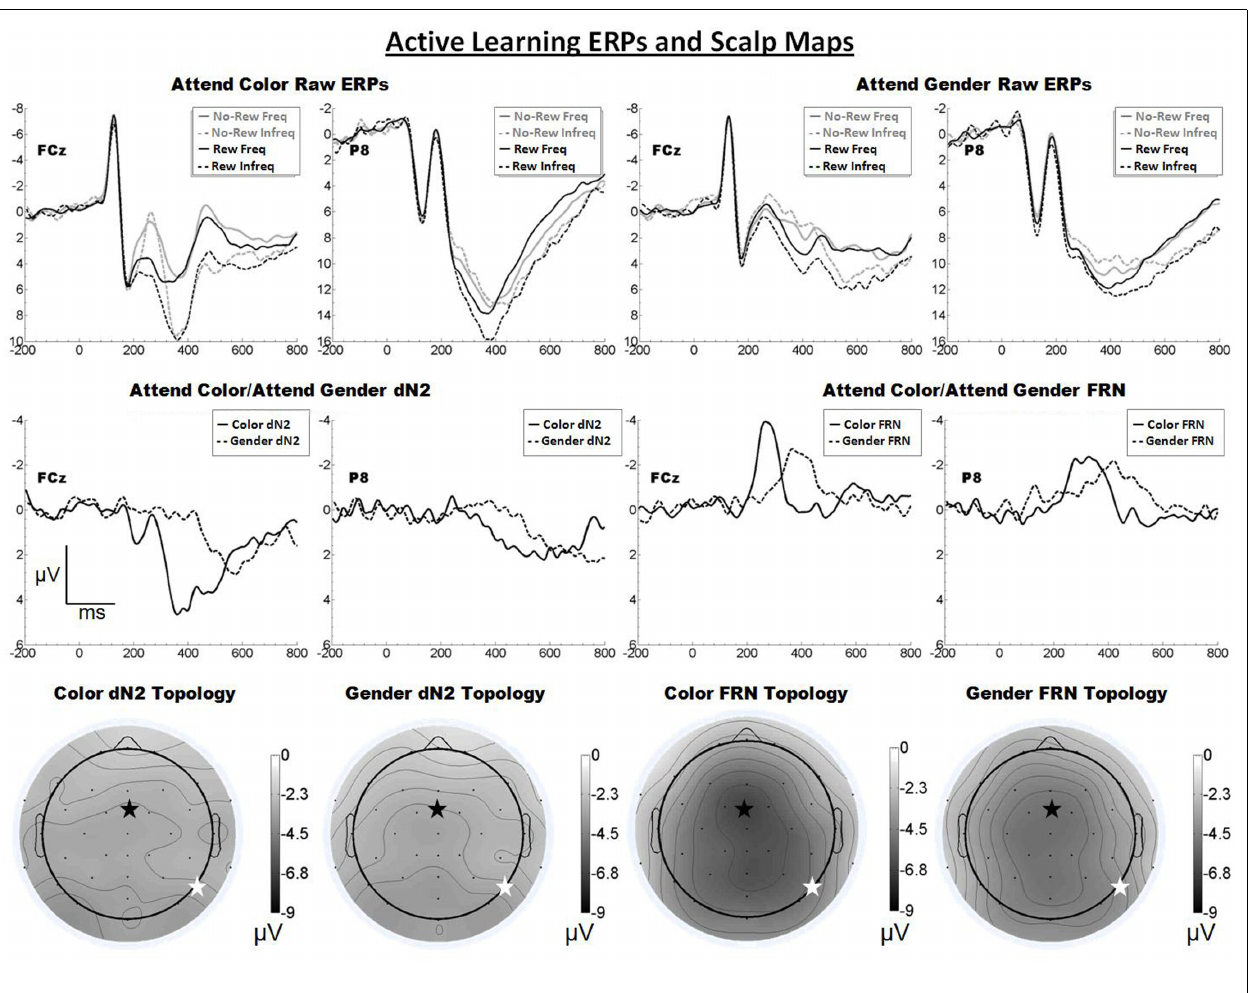
FIGURE 3 | Grand average ERPs for Experiment 2, recorded from channel FCz and P8 (see labels) and scalp distributions associated with the difference waves. The top row shows the “raw” ERPs for each of the frequency by reward conditions across tasks and electrodes.The middle row shows the dN2 and FRN difference waves across task and